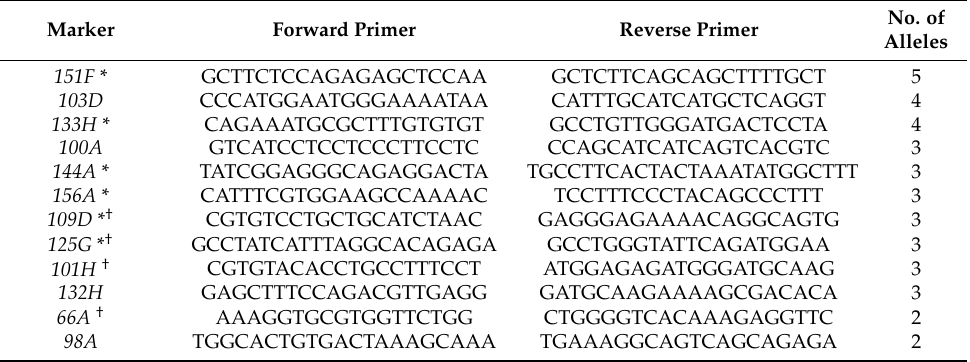
Table 2. A set of 18 polymorphic microsatellite markers chosen for paternity (parentage) analysis. Marker